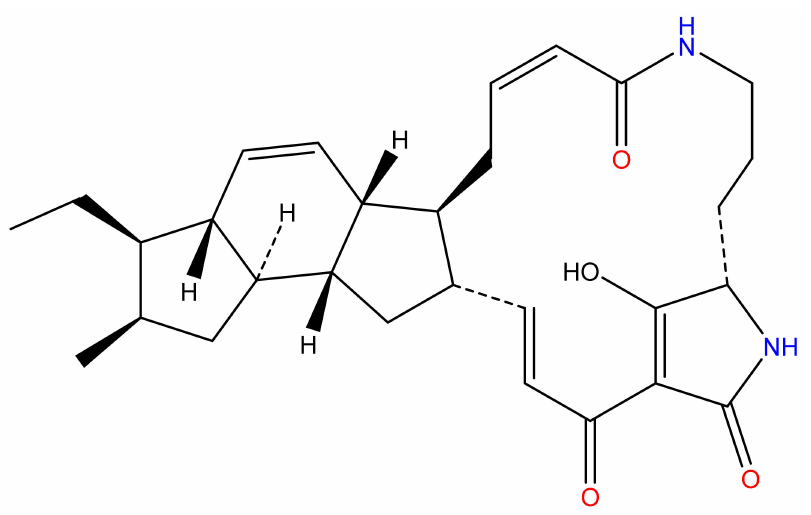
Figure 1. Structure of IKA, which consists of macrolactam ring, tetramic acids, and carbocycles [16]. Image was created using ChemDraw software 14.0 (PerkinElmer, Inc., Akron, OH,